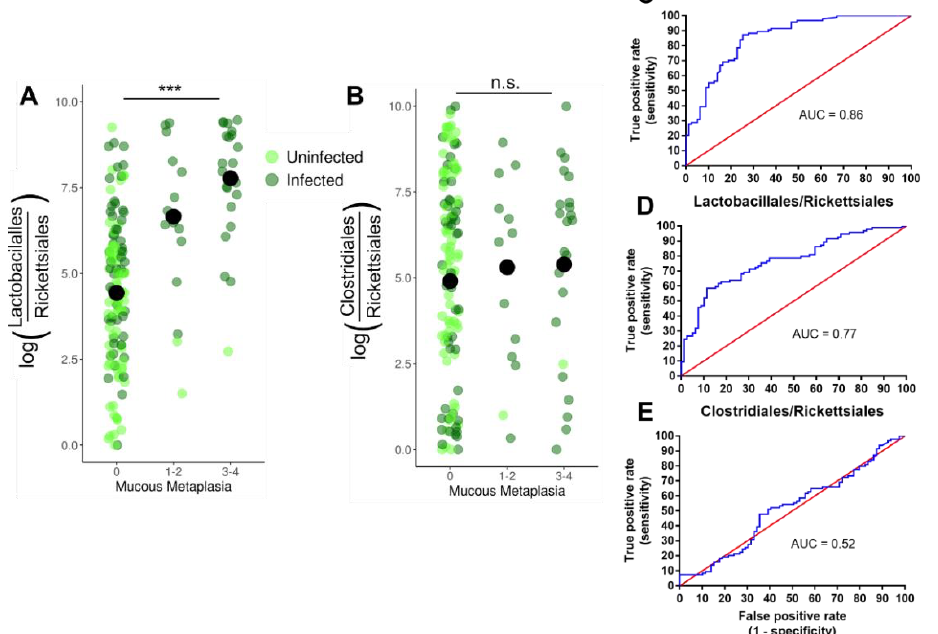
Figure 6. Predictive relationship between Lactobacillales and mucous metaplasia from Helicobacter infection. ( A , B ) Ordinal logistic regression analysis of log ratios of Lactobacillales/Rickettsiales ( A ), and Clostridiales/Rickettsiales ( B ) Relative abundance and gastric mucous histology score. The black circle marks the average of each category. Ordinal logistic regression was calculated using the polr command in R (*** p < 0.001). ( C – E ) ROC curve for log ratios of Campylobacterales, Lactobacillales, and Clostridiales to Rickettsiales. The blue line represents the performance of each ratio log fold-differential in predicting Helicobacter infection. The red line represents the result expected for a metric with a 50% chance of predicting infection. The area under the curve (AUC) value refers to the area under the blue line. Receiver operating characteristic (ROC) plots were constructed in Prism7 using log fold-differentials from Songbird and